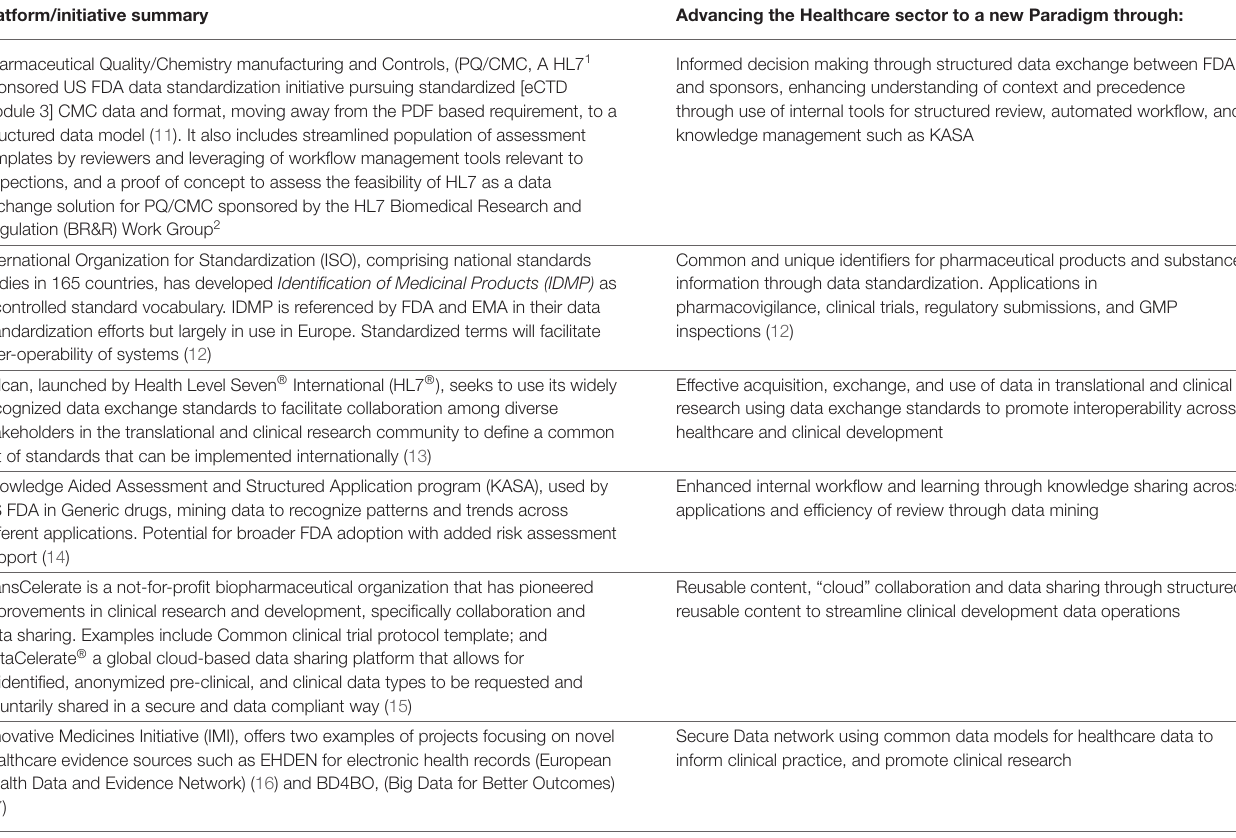
TABLE 1 | Examples of platforms/initiatives advancing data standardization, knowledge application, data sharing, and utilizing new forms of evidence. Platform/initiative